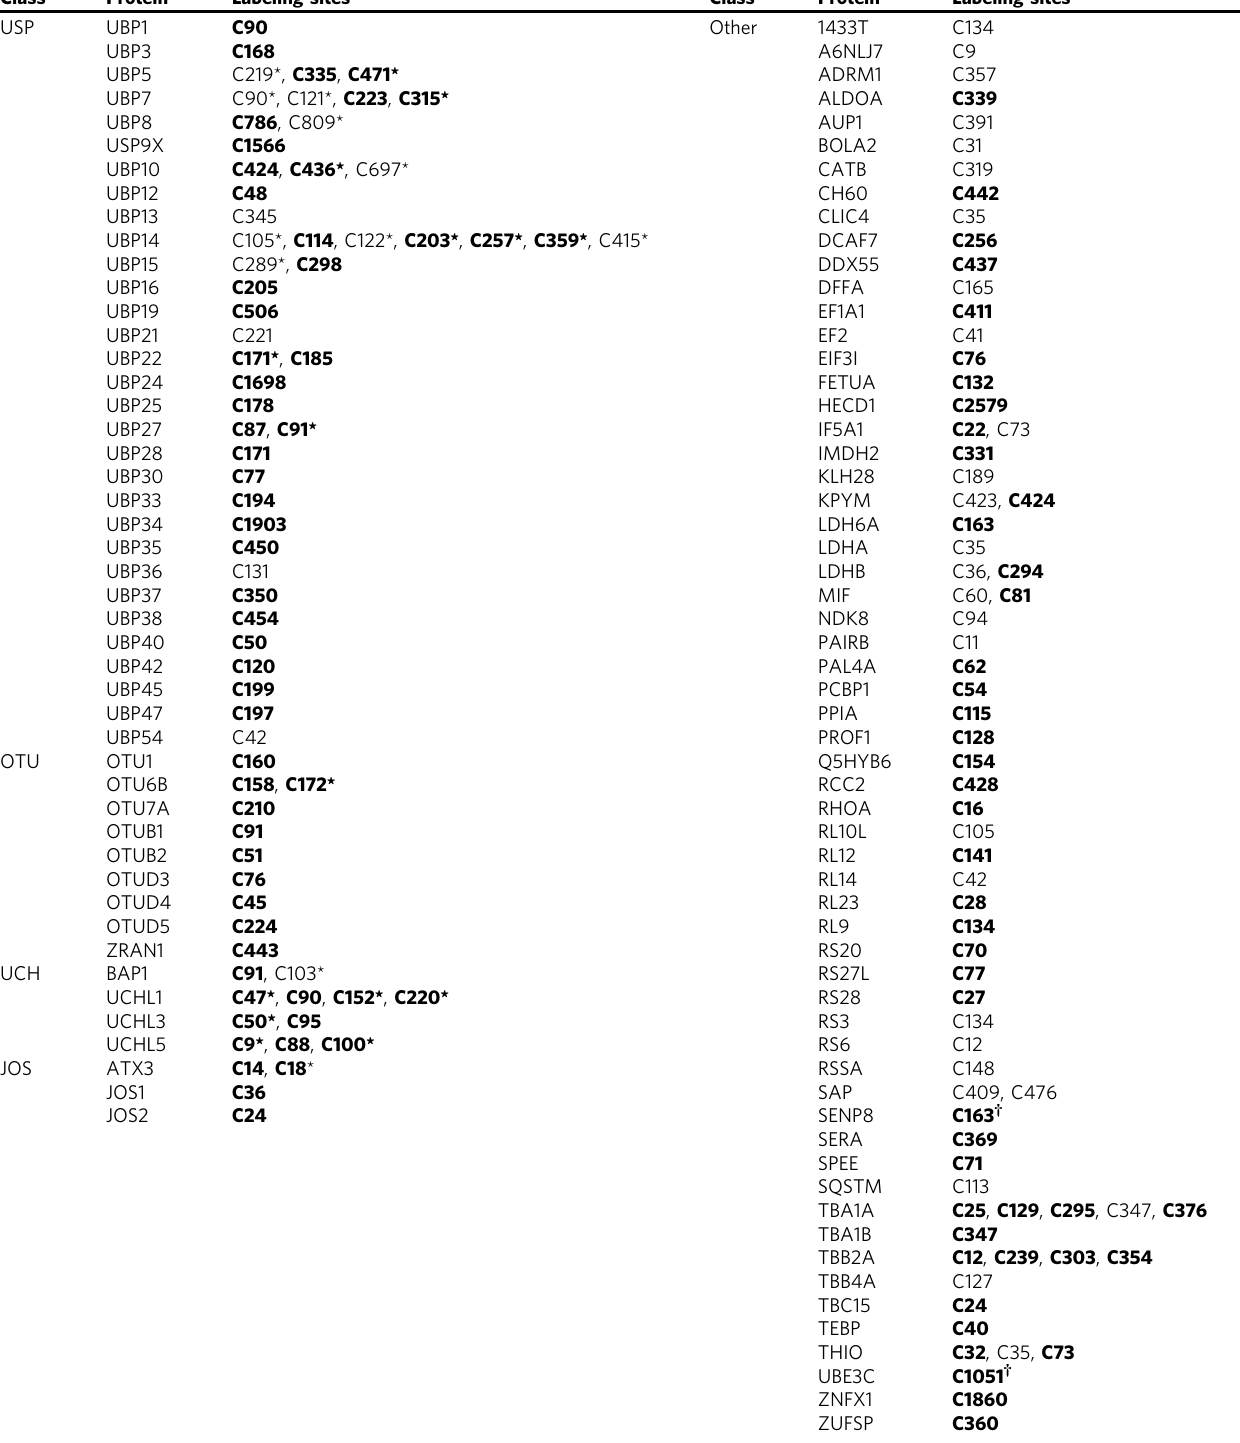
Table 1 | Ub-VPS-labeling sites identi fi ed in HEK 293T cell lysate